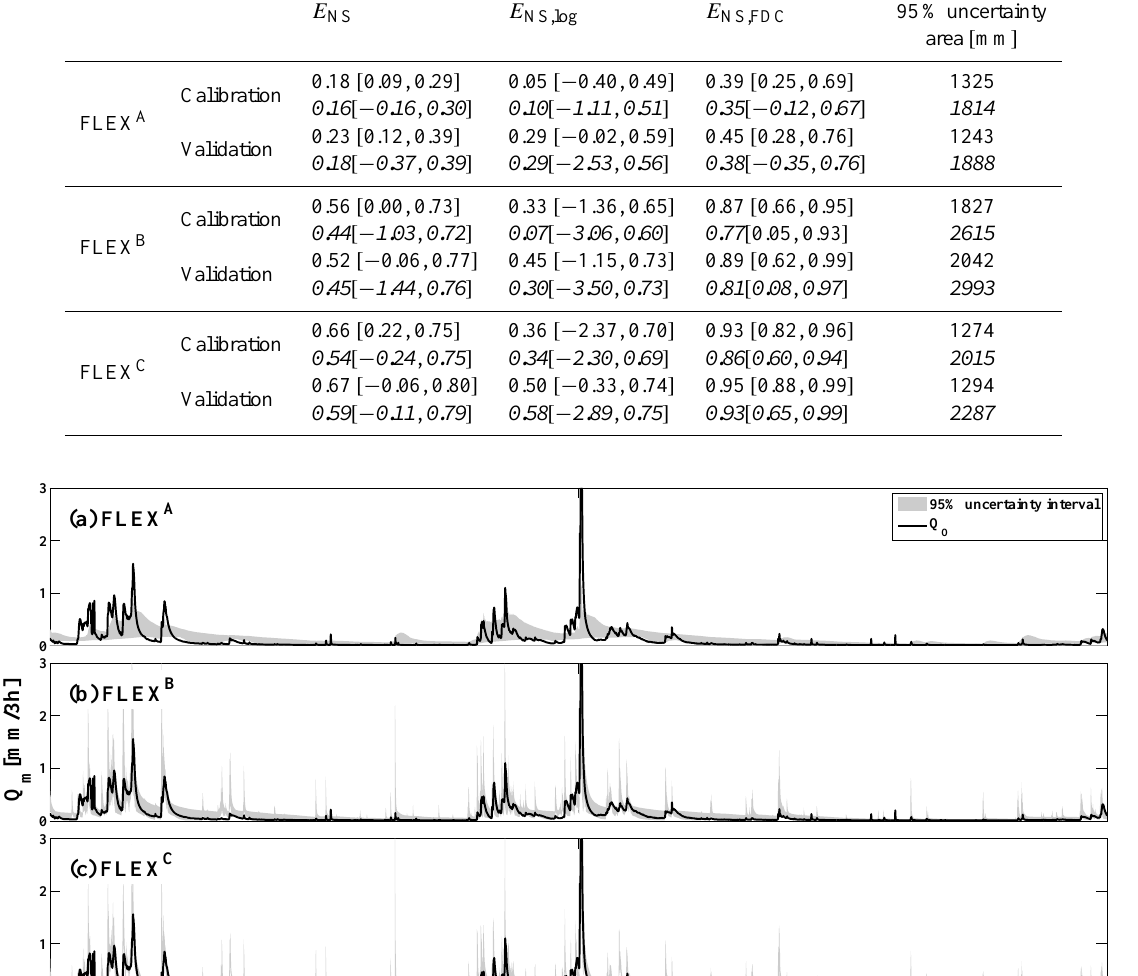
Table 4. The median model performances (in brackets their corresponding 95% uncertainty intervals) and the area spanned by the 95% uncertainty interval of hydrograph derived from uncalibrated parameter sets which satisfy the complete set of constraints for the three model setups FLEX A , FLEX B and FLEX C , for the three modeling objectives ( E NS , E NS,log , E NS,FDC ) in the calibration (2002–2005) and validation (2006–2009) periods. The italic values indicate performance and 95% uncertainty interval of hydrograph for the unconstrained benchmark models.